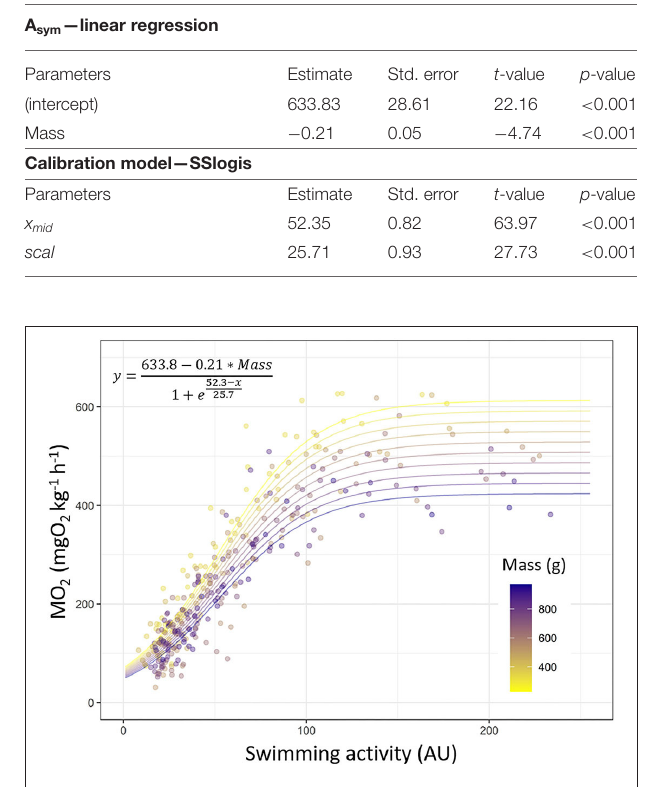
FIGURE 6 | Mapping the MO 2 values (mgO 2 kg − 1 h − 1 ) with the swimming activity (arbitrary unit, AU) measured by tag in European sea bass ( Dicentrarchus labrax ; n = 40). Prediction of the model [y = (633.8–0.21 * Mass)/(1 + exp((52.3–x)/25.7)); R ² = 0.88] was used to plot the different lines. Each dot indicates a value obtained during U crit trial. Dots and line color are referring to fish mass (from 200 to 1,000g; from yellow to dark blue).